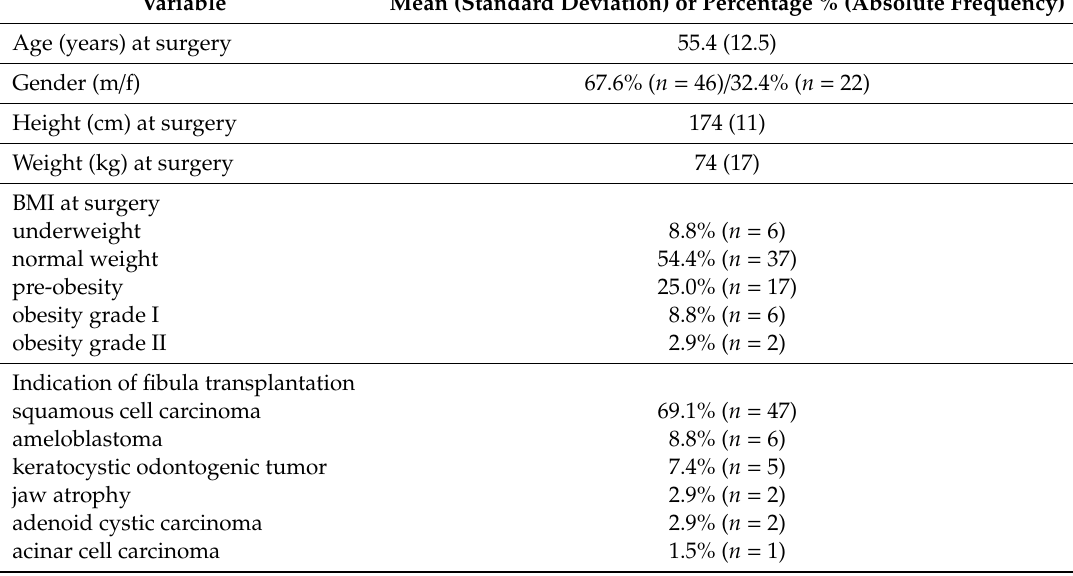
Table 1. A demographics table illustrate the collected data and subject population. Data are given as mean (standard deviation) or as percentage % (absolute